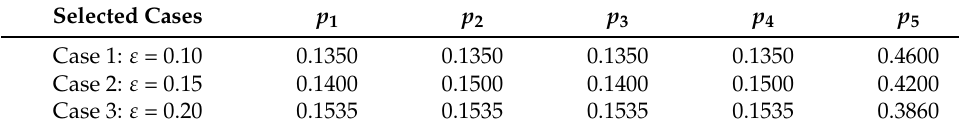
Table 2. Probability distributions included in the simulation study for k = 5.